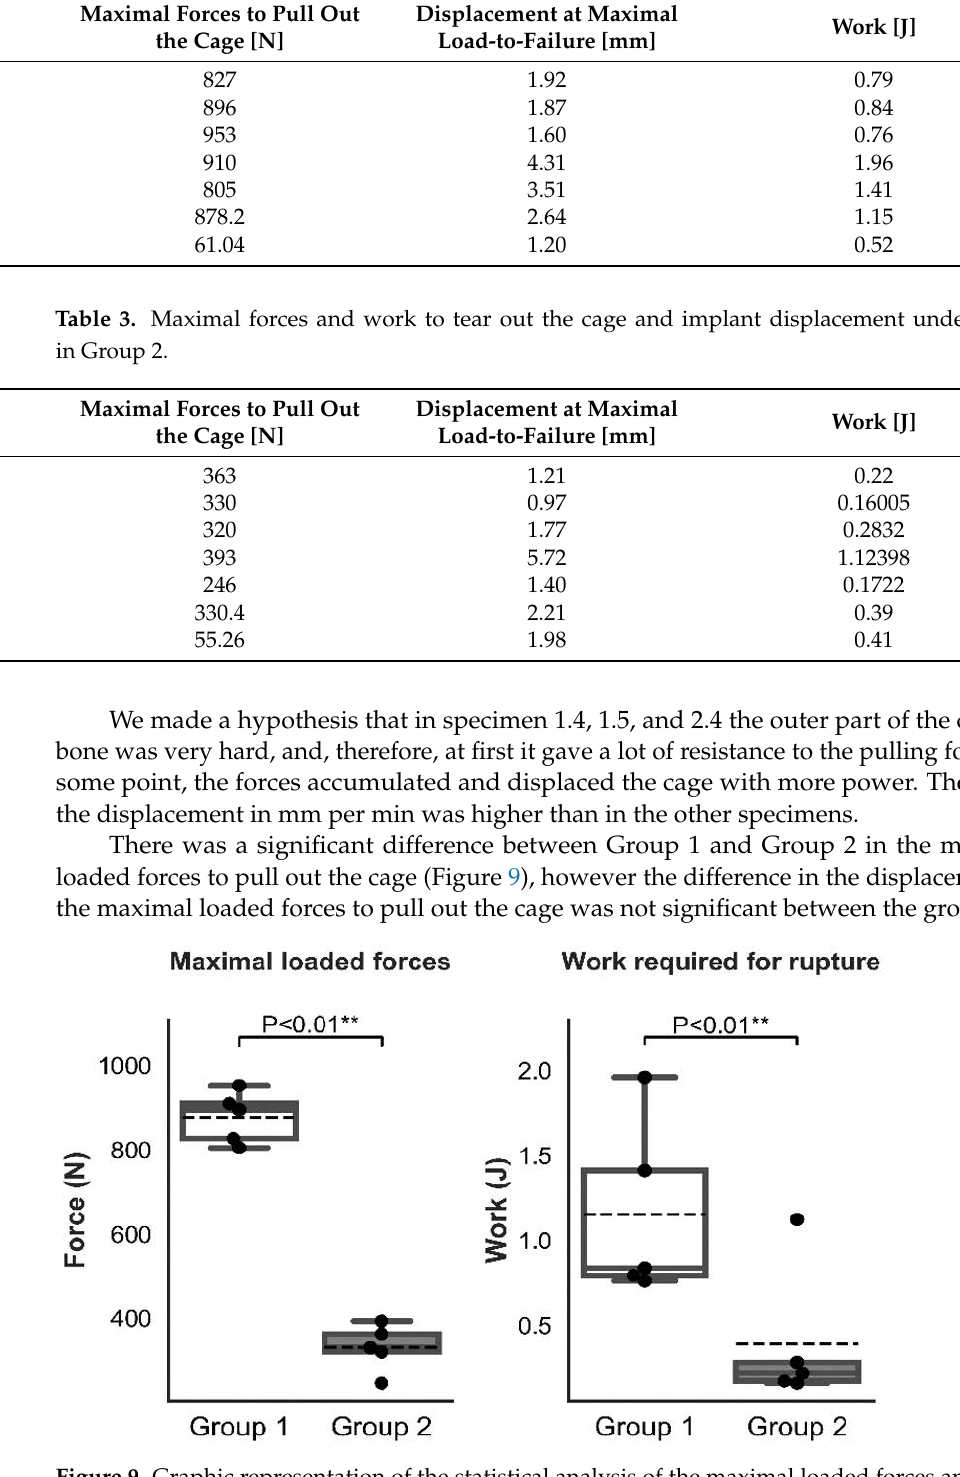
Figure 9. Graphic representation of the statistical analysis of the maximal loaded forces and work that was required for rupture in Groups 1 and 2. ( “**” mean high significance, i.e., less than 0.01